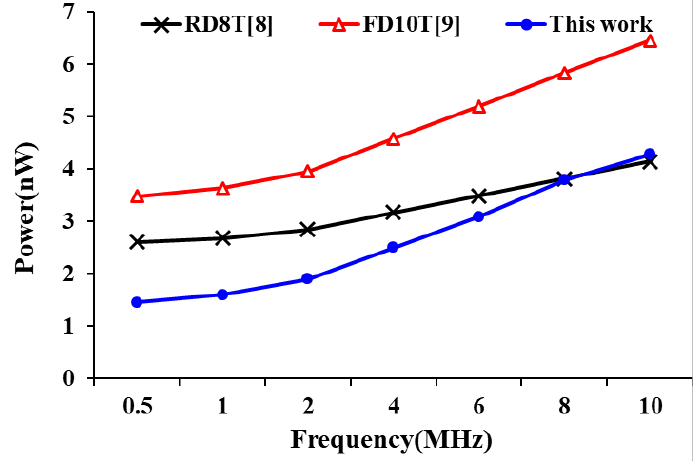
Figure 14. Power consumption of bit-cell at different operation frequency.